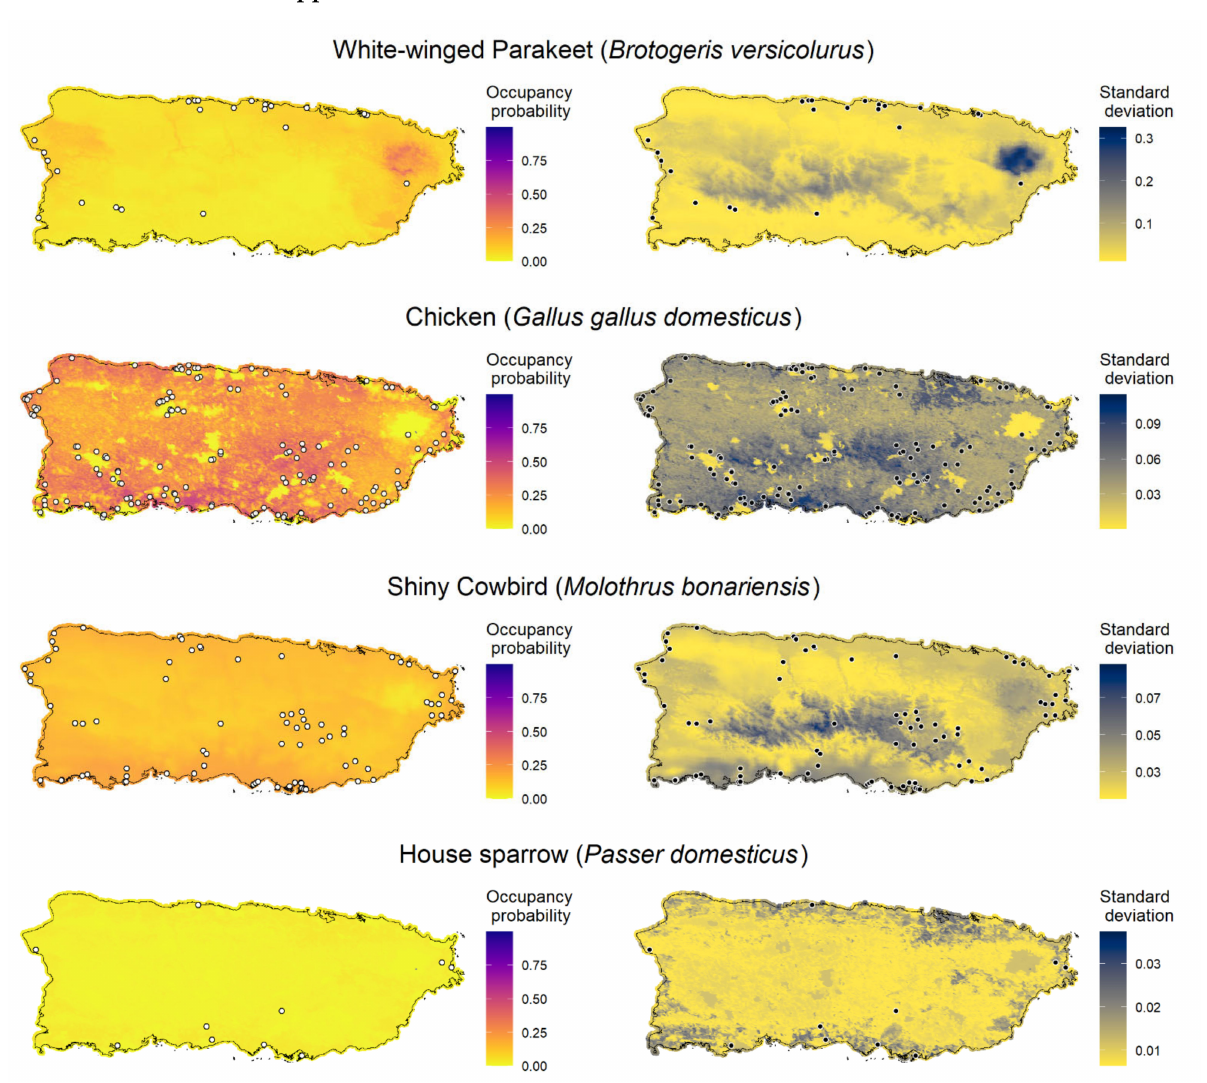
Figure A18. Cont